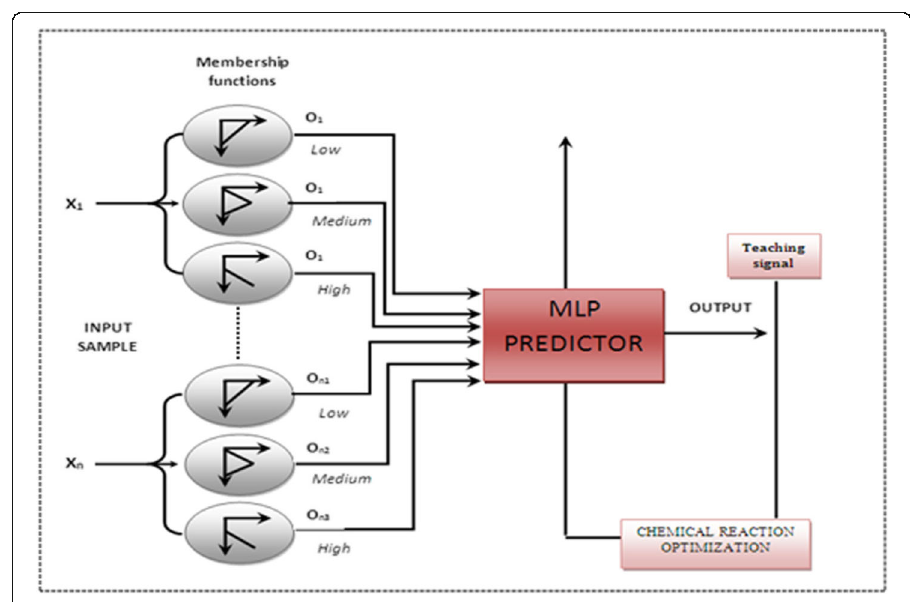
Fig. 4 Architecture of CNFN based forecasting